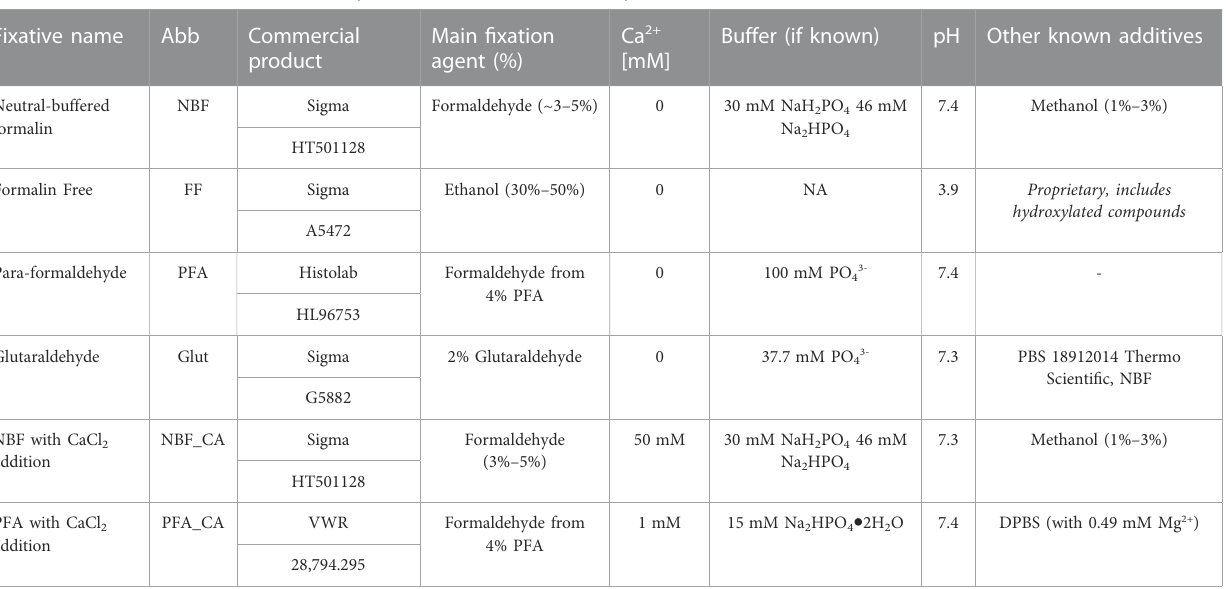
TABLE 1 Overview of commercial and laboratory made fi xatives used in this